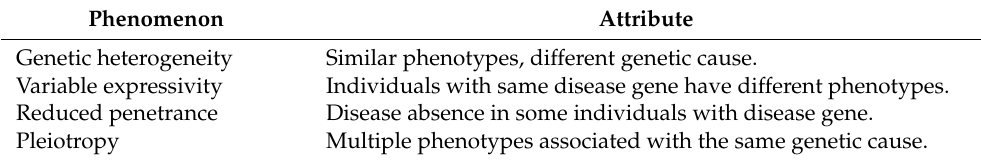
Table 1. Definition of genetic